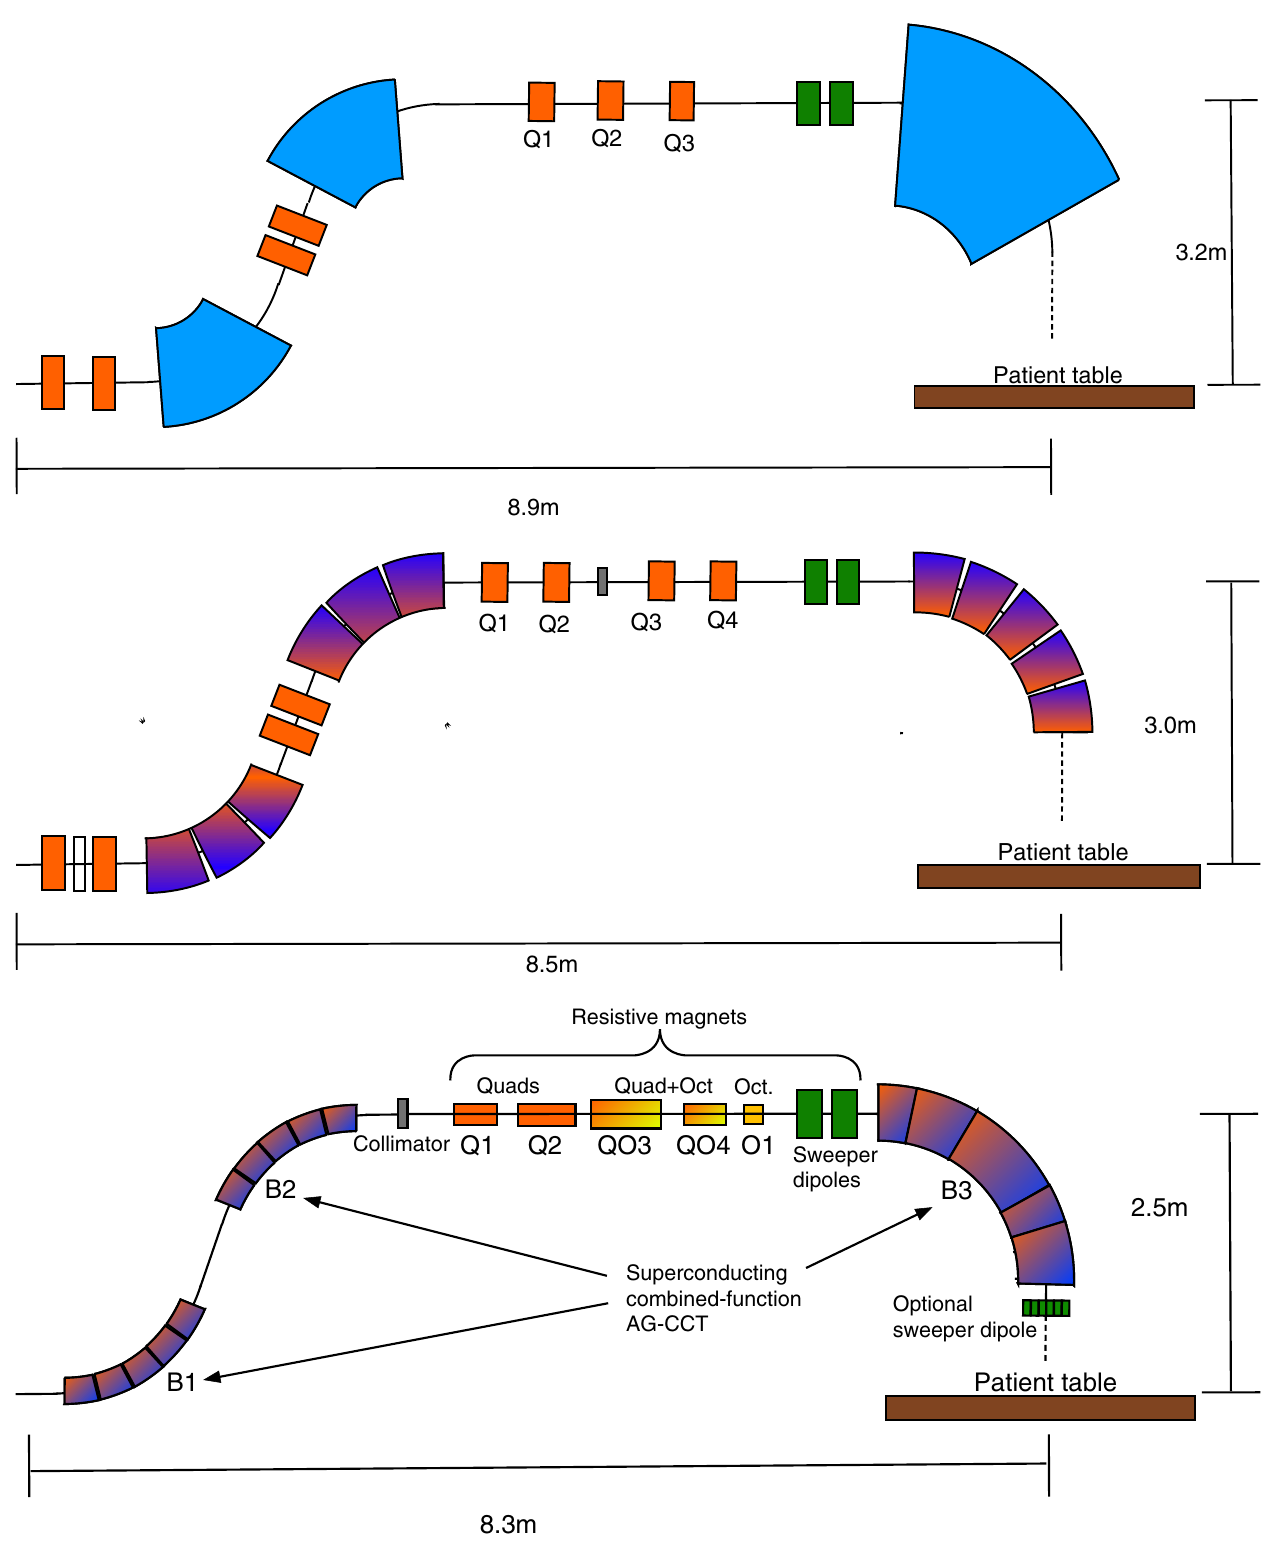
FIG. 1. Three gantry layouts: PSI gantry II (top); a possible achromatic design, as presented in [7] (middle); the layout developed in this paper, i.e., an achromatic gantry using three AG-CCT magnets (bottom). The magnets shaded with two colors are of a combined function type: dipole þ quadrupole